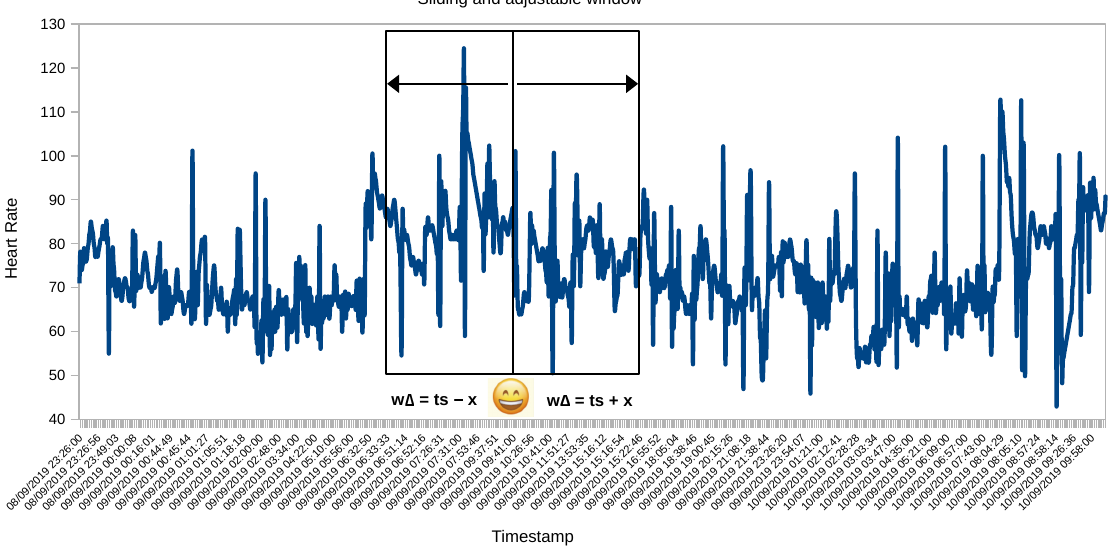
Figure 7. A participant’s sample of HR data with the configuration of a dynamic window adjusted to the HR and emotion